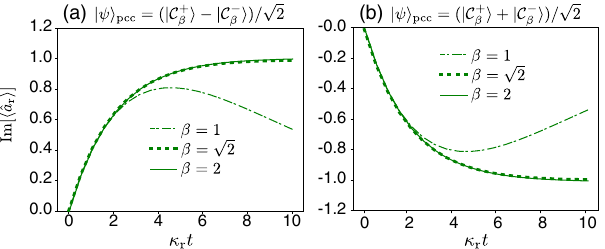
FIG. 18. Evolution of the I quadrature [ i ð ˆ a † r − ˆ a